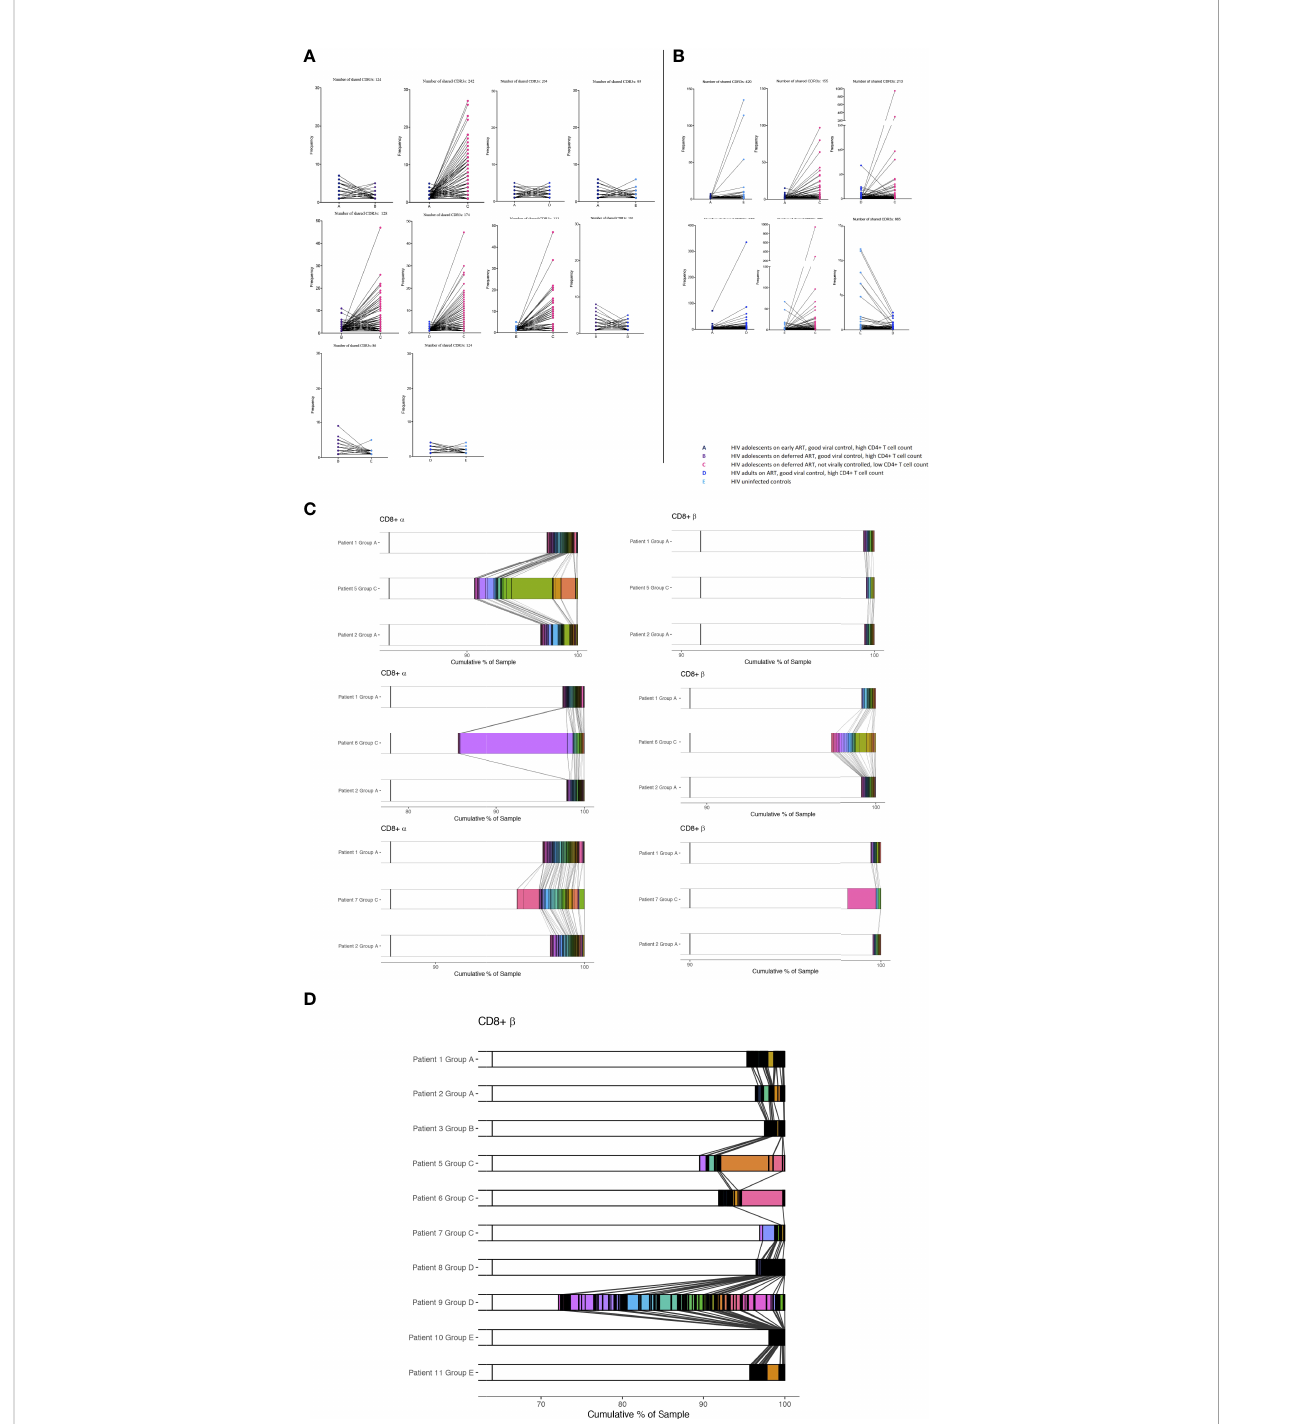
FIGURE 3 The abundance differences of the public TCR repertoire in children with different responses to HIV-1. The y axis shows the abundance of shared TCRs (dots) between groups. Lines are connecting identical shared TCRs between two groups. (A) CD4 + TCR repertoires and (B) CD8 + TCR repertoires. (C, D) Shared CDR3s between patients from CD8 + T cells are shown with connecting grey lines. Left panels show a chain samples; right panels show b chain samples. The horizontal bar represents a sample, with white space showing the percentage of CDR3s unique to that sample within each panel, and these constitute the majority of each sample. Within each of the six panels, all the CDR3s occurring in more than one sample are coloured and separated by black outlines, thus many CDR3s shared at low frequencies appear black. A broad coloured band indicates that the CDR3 has expanded multiple times. Within each panel, a given colour represents the same CDR3; grey lines overlaid show pairwise shared